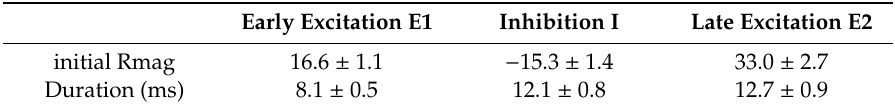
Table 1. Characteristics of the triphasic response of SNr neurons evoked by ACC electrical